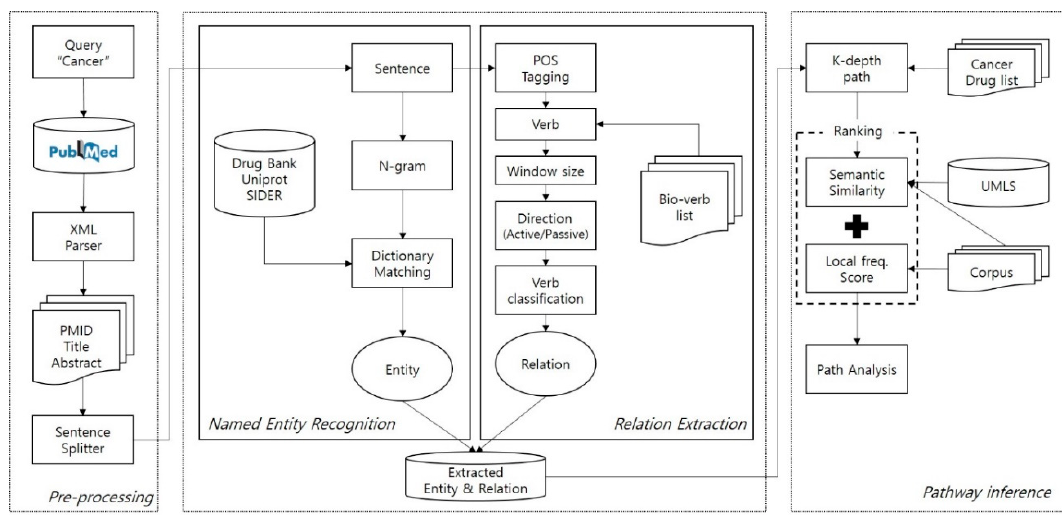
Figure 1. System overview.